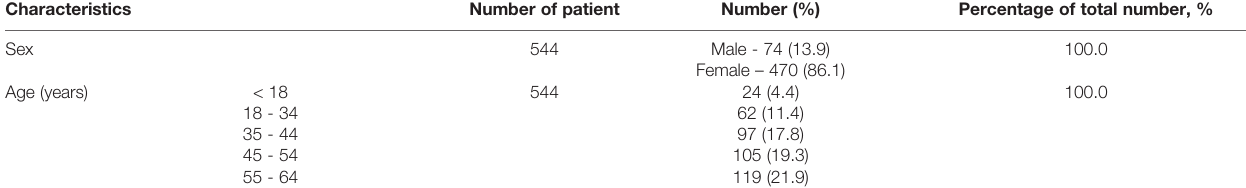
TABLE 1 | Demographic characteristics of group patients with